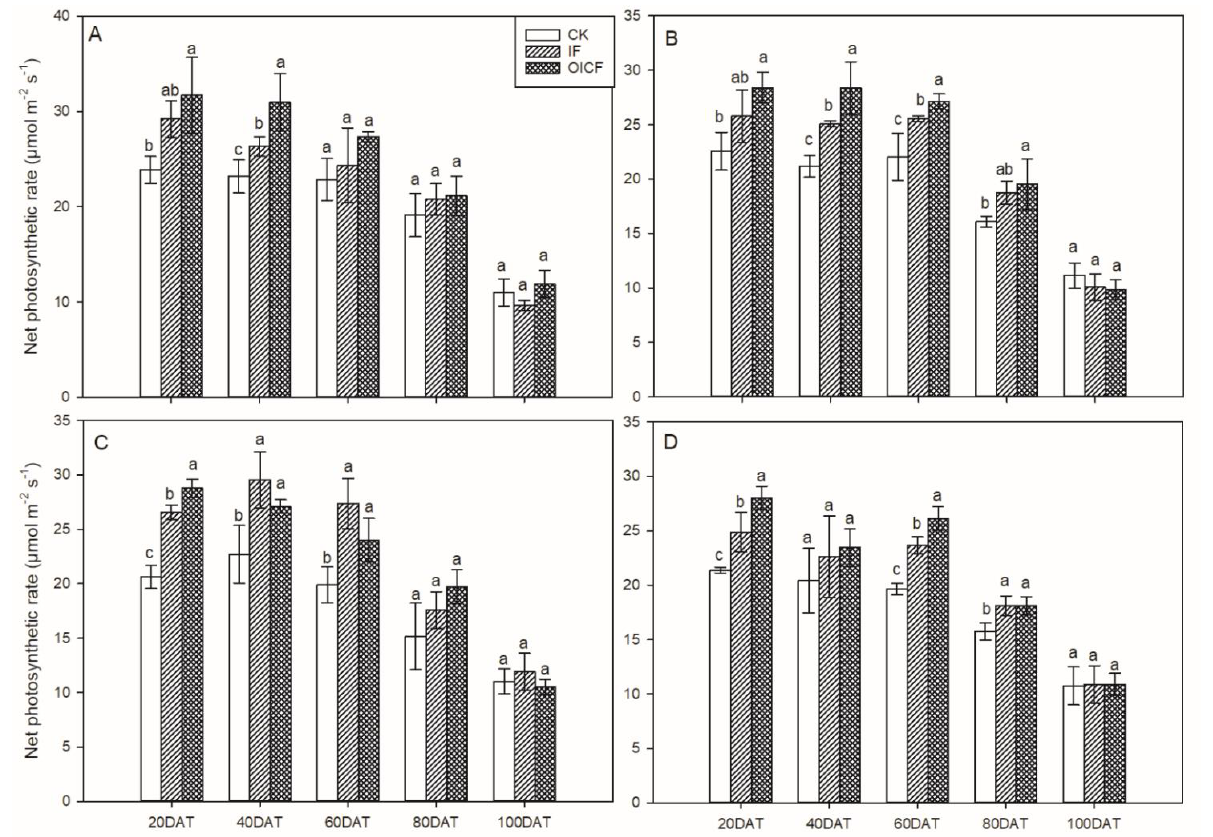
Figure 1. Effects of new organic-norganic compound fertilizer on the net photosynthetic rate of fragrant rice in 2017 ( A ), 2018 ( B ), 2019 ( C ), and 2020 ( D ). Bars sharing a common letter do not differ significantly at p ≤